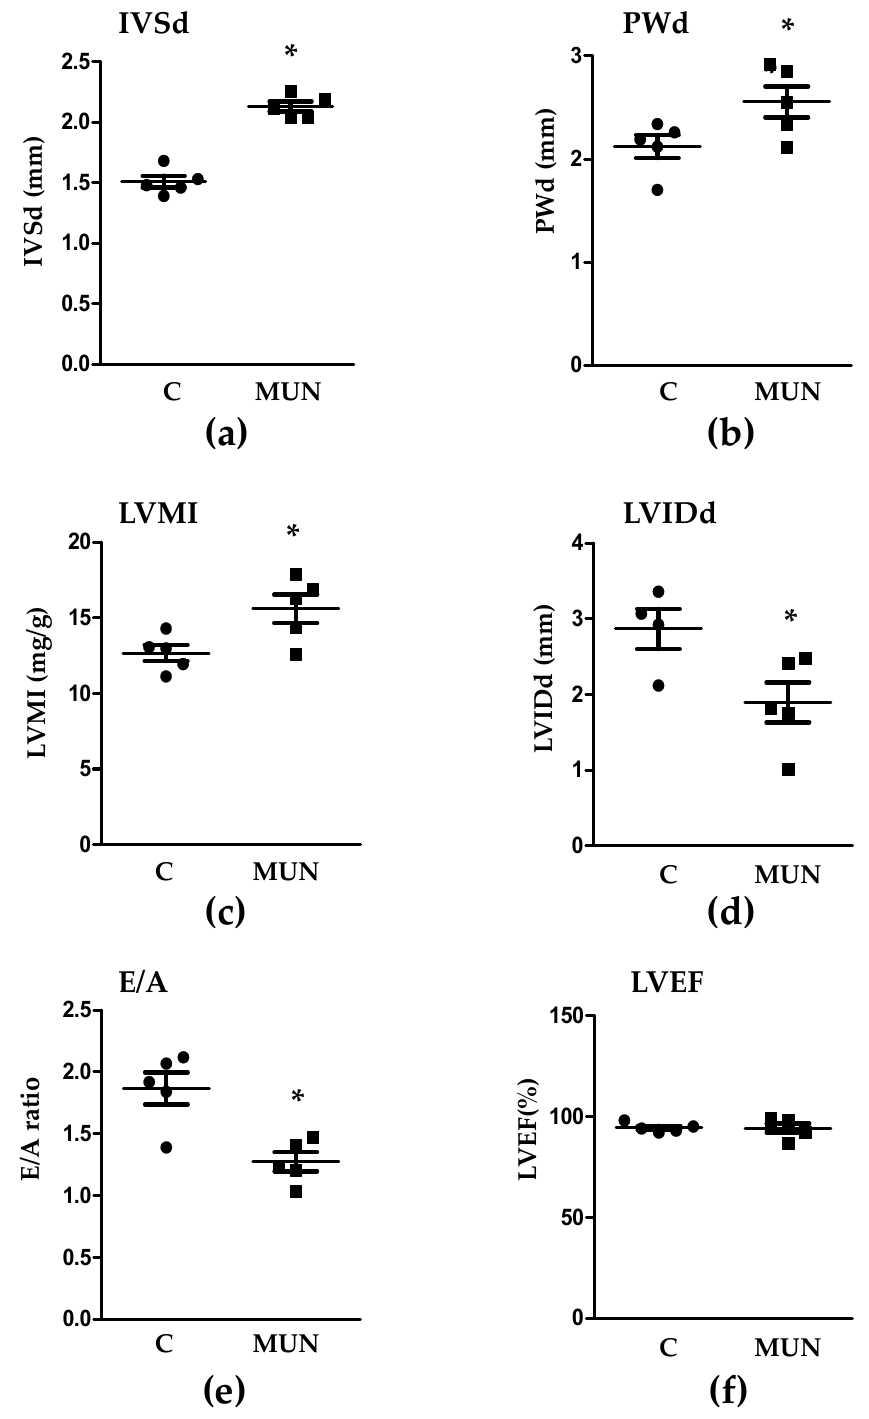
Figure 1. Echocardiographic parameters in 21-day old male offspring from rats exposed to maternal undernutrition during pregnancy (MUN) and control rats fed ad libitum (C). ( a ) IVSd, interventricular septum thickness at diastole; ( b ) PWd, posterior wall thickness at diastole; ( c ) LVMI, left ventricular mass index; ( d ) LVIDd, left ventricular internal diameter at diastole; ( e ) E/A, E, mitral peak early-filling velocity, and A, mitral peak flow velocity at atrial contraction; ( f ) LVEF, left ventricular ejection fraction. Sample size per group: 6 rats from 5 litters. Student’s t test, * p < 0.05 compared to C rats.